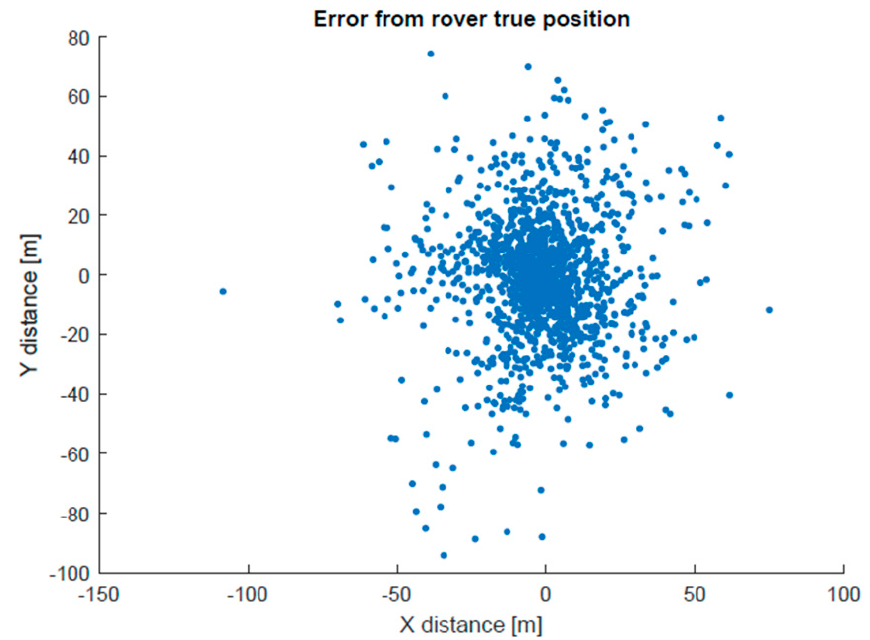
Figure 5. Example of position error distributions (receiver observation errors ∆ ∇ ω ( 2 × σ ∆ ∇ (cid:2985) ) = 0.4 m).